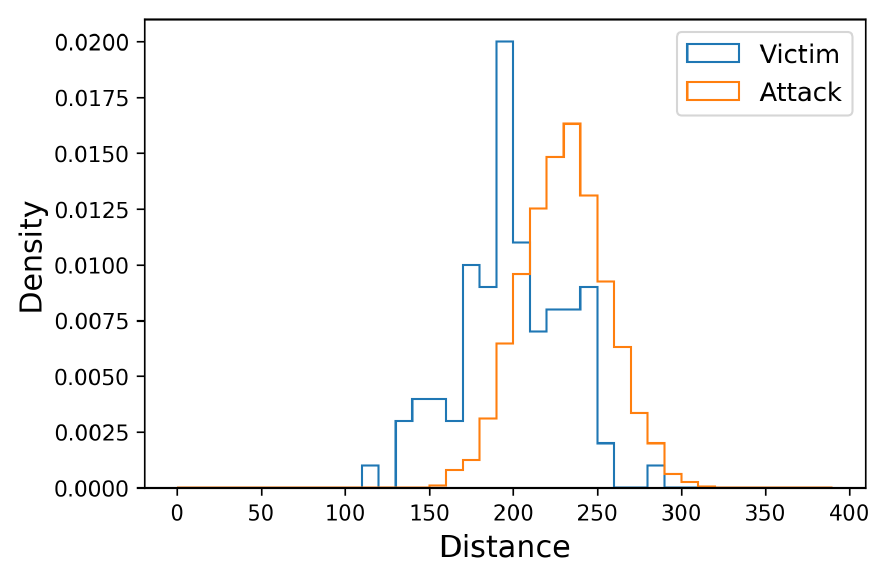
Figure 2. Distribution of the distance of attacker and victim from the victim’s gait template.